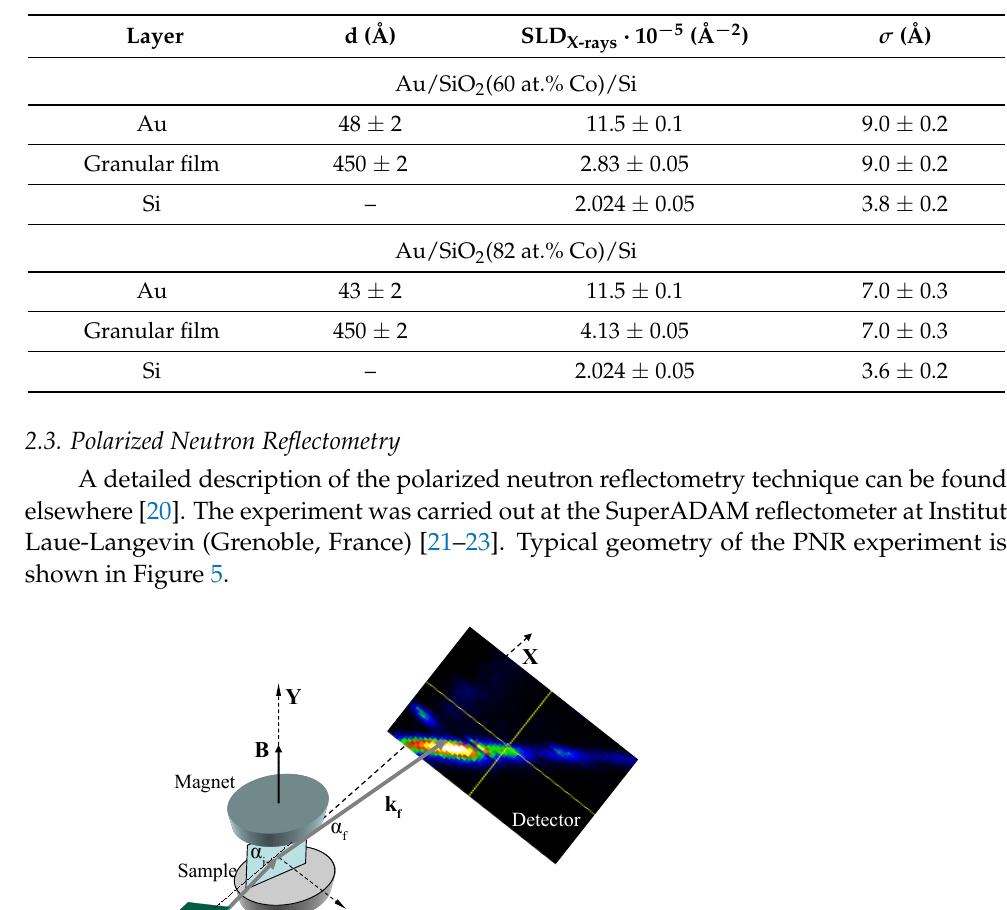
Table 1. Parameters of the model used to approximate the experimental X-ray reflectometry curves.